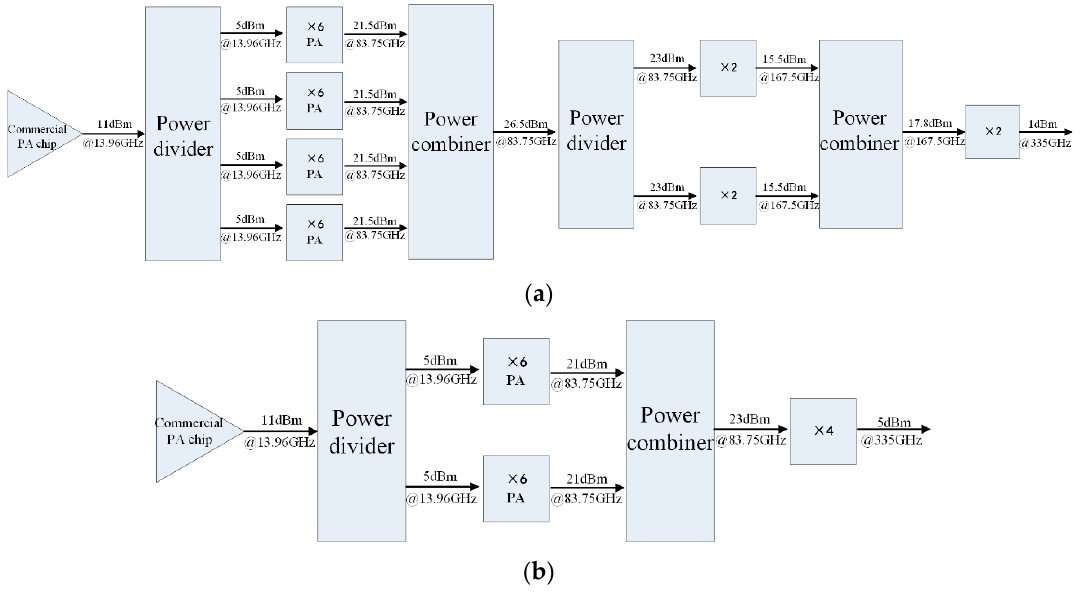
Figure 1. ( a ) Block diagram of the 335 GHz frequency multiplier based on a two-stage doubler. ( b ) Block diagram of the 335 GHz frequency multiplier based on a single-stage quadrupler.